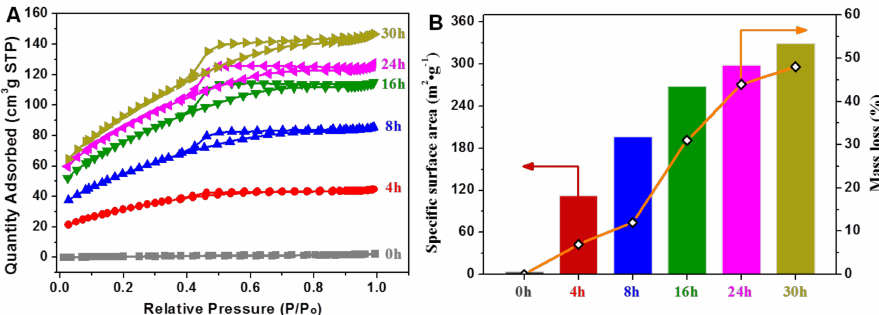
Figure 4. N 2 adsorption-desorption isotherms ( A ) and weight loss (open circles) and specific surface area (columns) modification of the acid treated carbon-based materials as a function of the treatment duration ( B